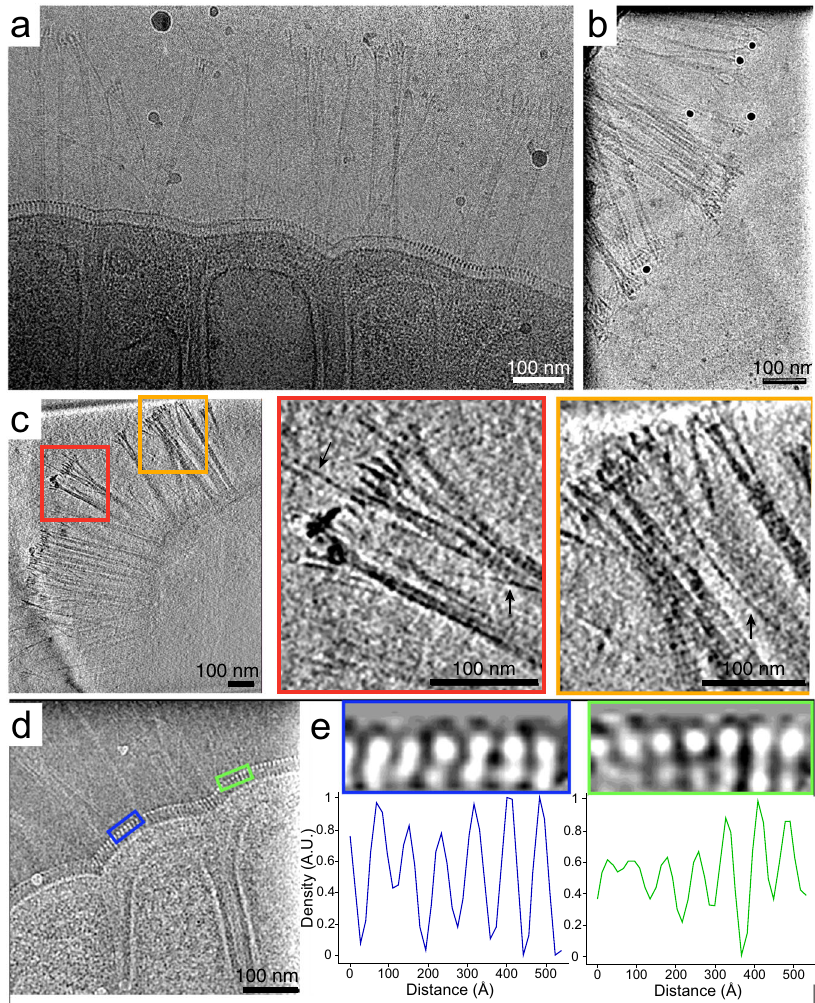
Fig. 7 | RBS-A surface features include appendages in heterogeneous bundles that splay out at the tips and a periodic surface covering around the entire RBS-A. a Single cryoTEM image. b , c CryoET slices (~3-nm thick) of an RBS-A. Red and orangeboxesin( c )are magni fi edviews of bundlesof appendages, and arrows